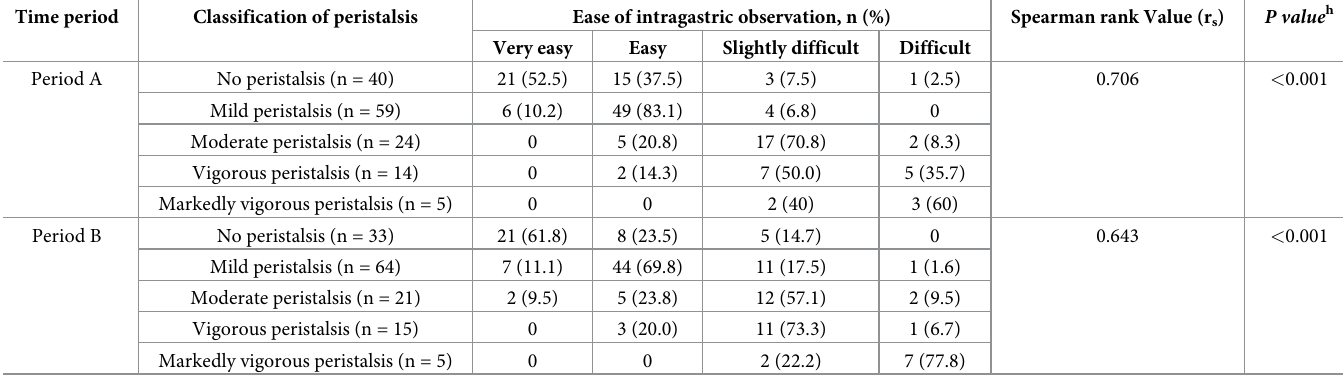
Table 4. Correlation between the classification of peristalsis and ease of intragastric observation.